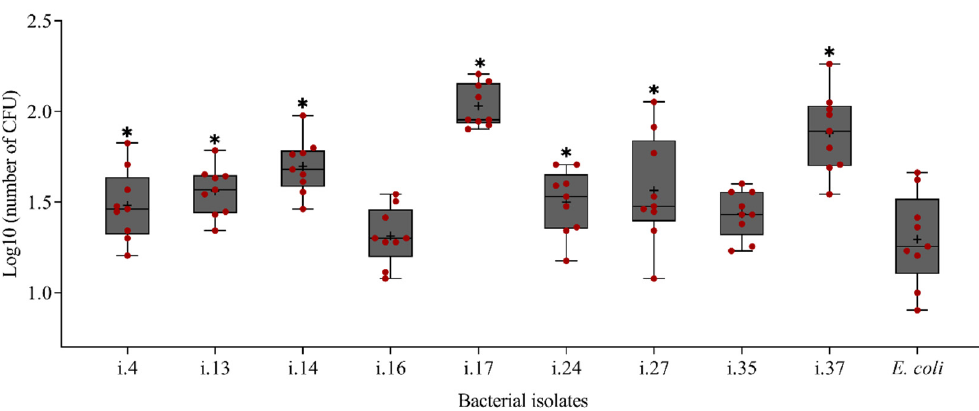
Figure 5. Attachment capacity of bacterial isolates from infective stages of Pratylenchus penetrans to the cuticle of P. penetrans . Nematodes were incubated in suspensions of the bacteria in water, washed on sterile sieves, and plated on R2A media. Escherichia coli JM109 was used as a negative control. Mean log transformed numbers of CFU are shown as (+) for each strain, the medians are shown as (—), whiskers indicate quartiles. Stars above whiskers indicate significant differences compared to the control E. coli (Dunnett’s test, n = 9).